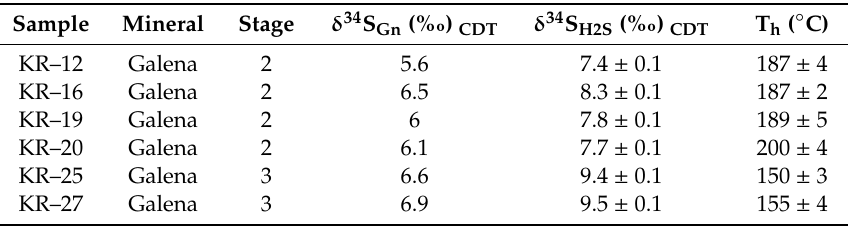
Table 3. Sulfur isotope data for galena from the Kuergasheng Pb–Zn deposit. Sample